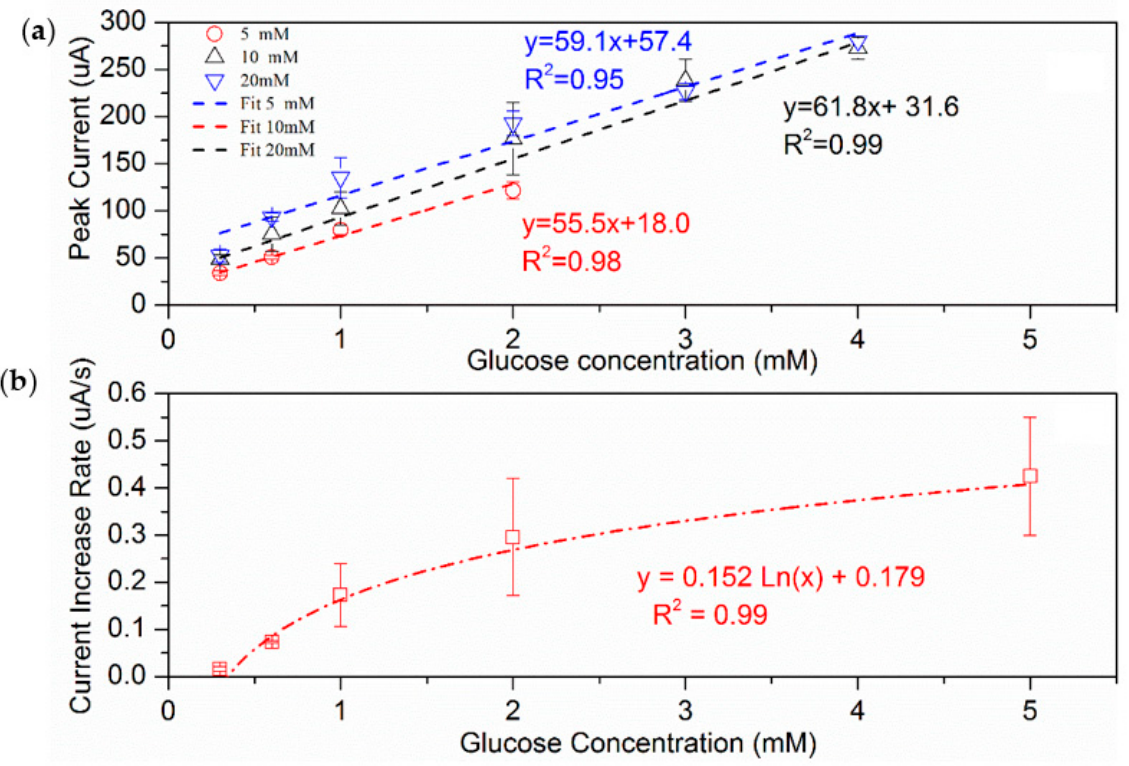
Figure 6. ( a ) The linear correlations (glucose concentration vs. peak current) of the CS with different glucose concentrations; ( b ) the rate of current increase (at 100 s) with different glucose concentrations in the CS (cultured with 5 mM glucose solution).